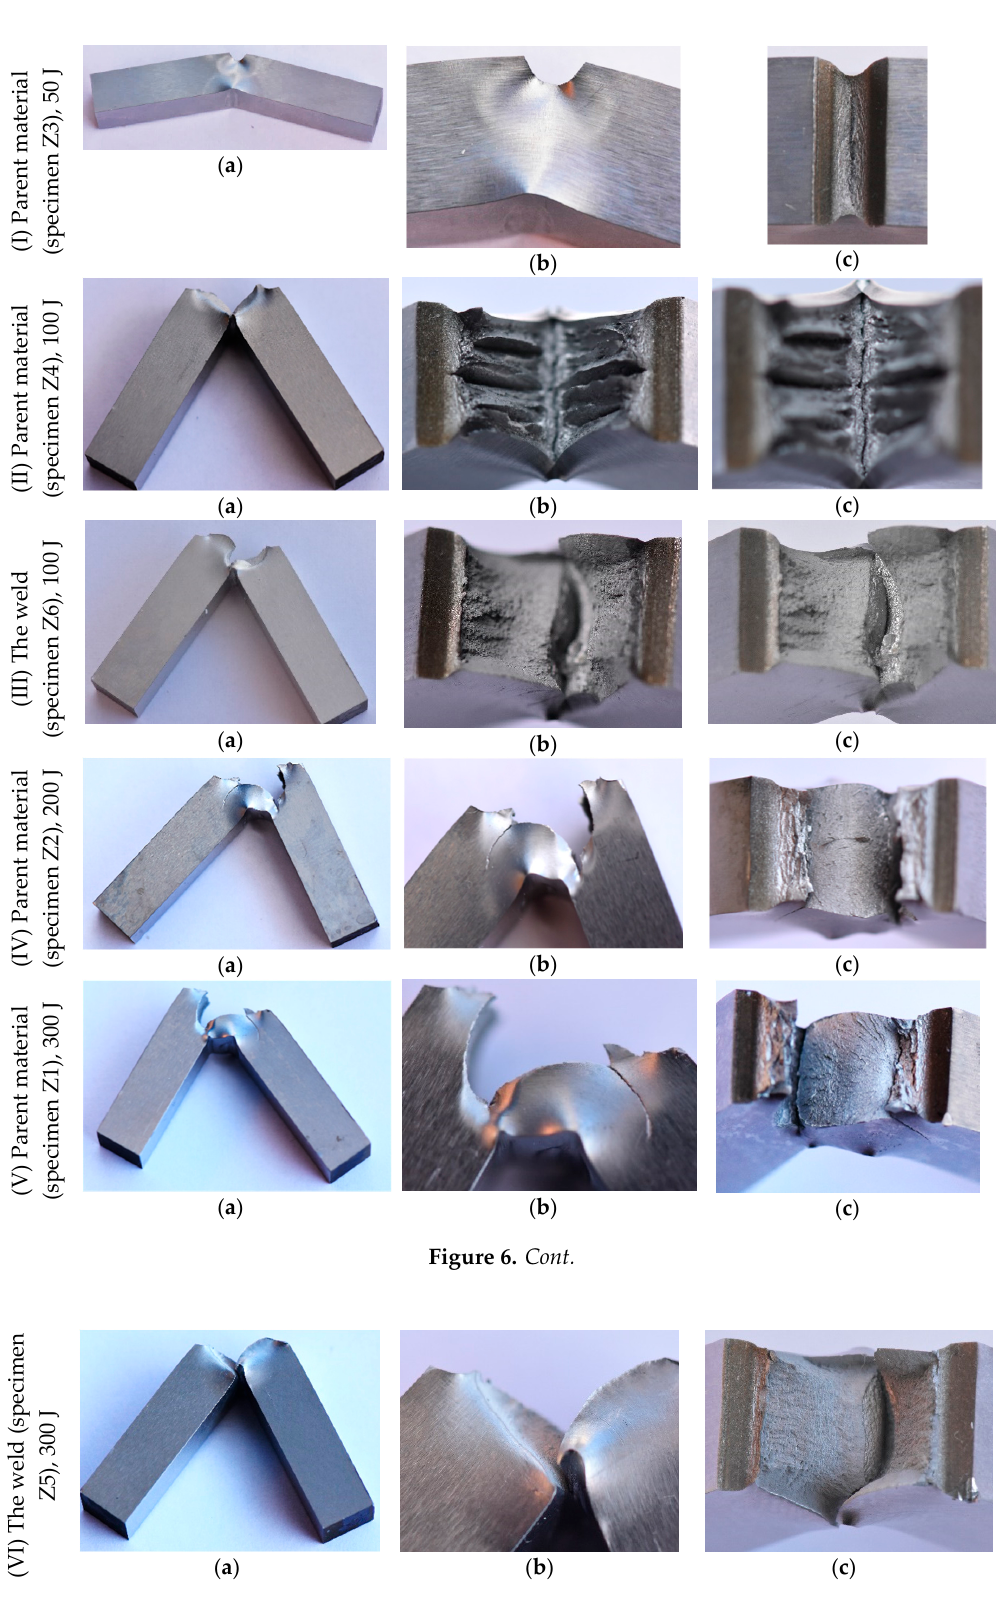
Figure 5. Variations of the Charpy test parameters for the S700MC steel (parent material) under impact energy of: ( a ) 50 J; and ( b ) 200 J.